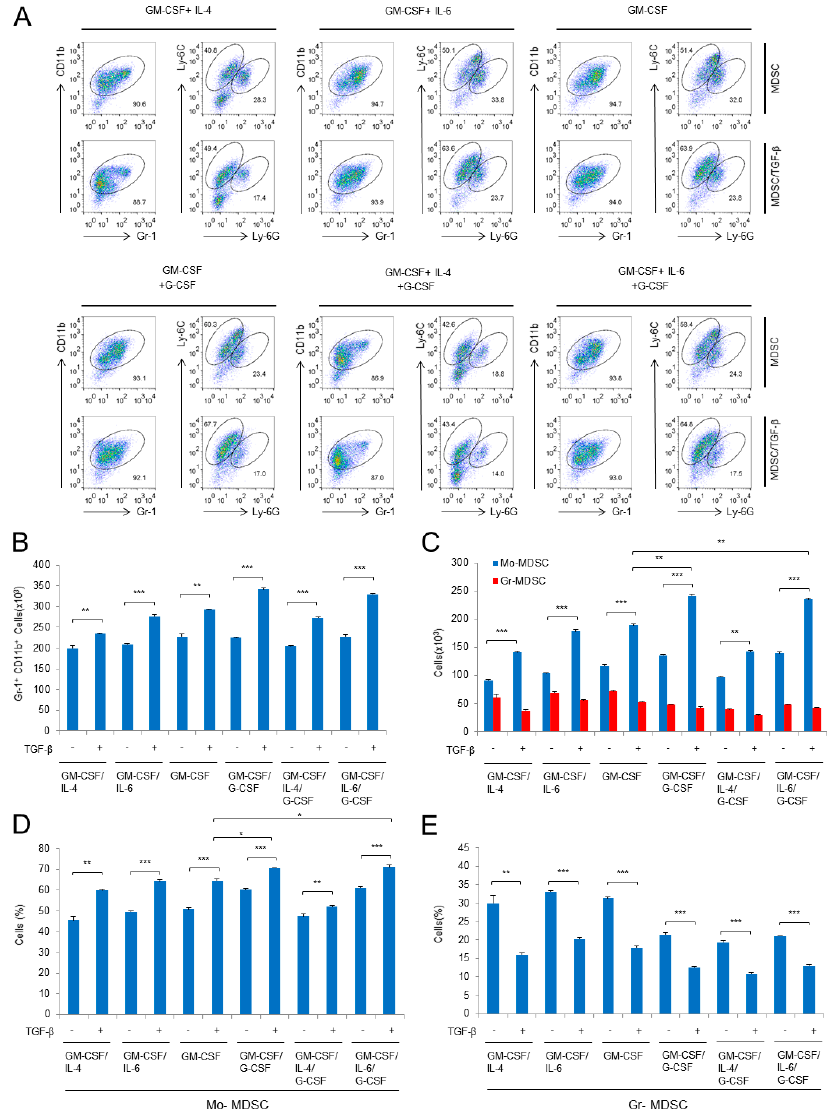
Figure 1. Induction of myeloid-derived suppressor cells (MDSCs) is affected by different combinations of cytokines and by the presence/absence of transforming growth factor- β (TGF- β ). ( A ) Flow cytometric analysis of in vitro-induced MDSCs. Bone marrow cells from female mice (6 weeks old) were cultured for 3 days with six different combinations of cytokines; ( B ) cell numbers were analyzed by gating on the Gr-1 + CD11b + population; ( C ) number of cells in different MDSC subpopulations; ( D , E ) percentage of monocytic-MDSCs (Mo-MDSCs) ( D ) and granulocytic-MDSCs (Gr-MDSCs) ( E ). GM-CSF, granulocyte-macrophage colony stimulating factor; IL-4, interleukin-4; IL-6, interlukin-6; G-CSF, granulocyte colony stimulating factor; Data are representative of three independent experiments in triplicate ( B – E ), and the results are expressed as the mean ± SD. * p < 0.05, ** p < 0.01, *** p < 0.001 (Student’s t test) ( B – E ).